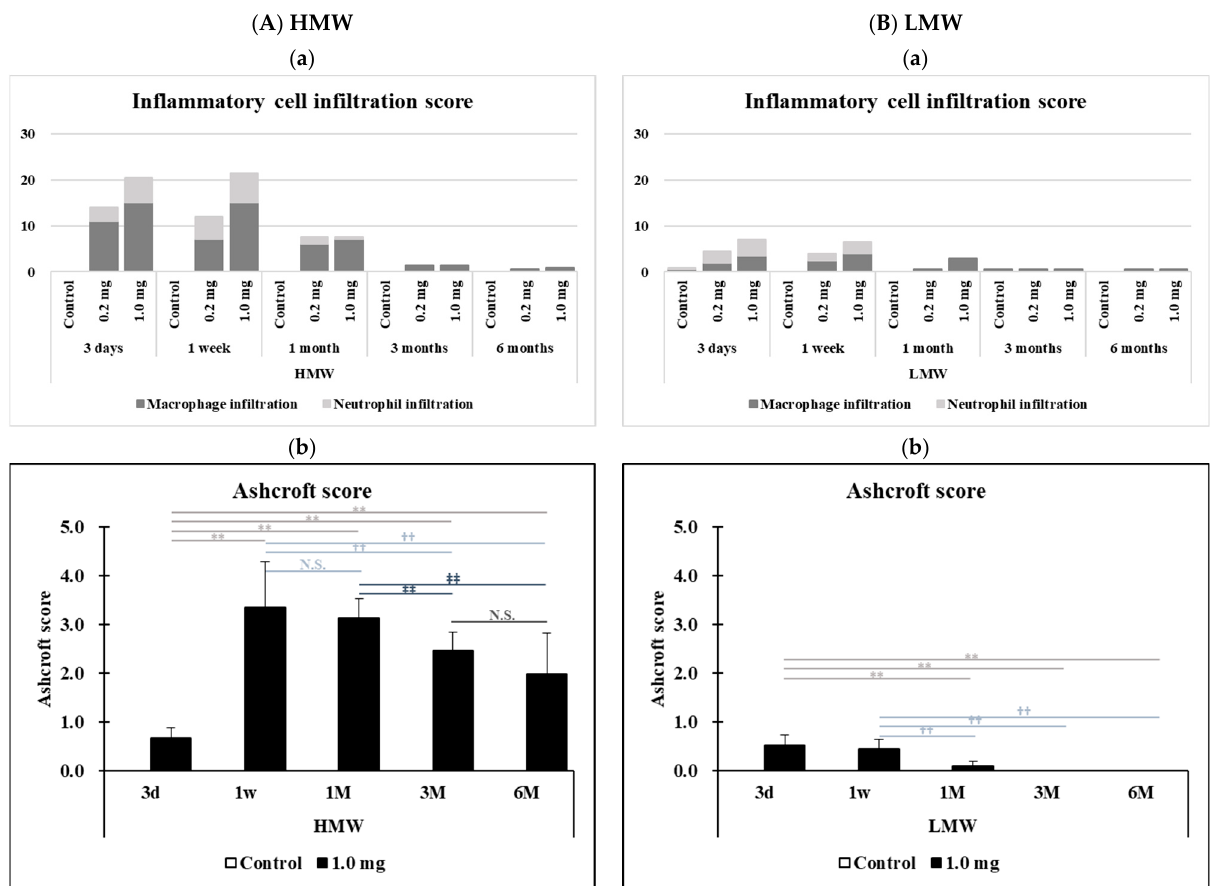
Figure 8. The histological evaluation of lung lesions. ( A ) HMW PAA-exposure group and ( B ) LMW PAA-exposure group, where ( a ) inflammatory cell infiltration score among the control, 0.2 mg-exposed, and 1.0 mg-exposed groups, and ( b ) Ashcroft score in the control group and 1.0 mg-exposure group. Inflammatory cell infiltration was observed in a dose-dependent manner, and was more severe and lasted longer in the HMW PAA-exposure group than in the LMW PAA-exposure group ( A ( a ), B ( a )). Pulmonary fibrosis was seen throughout the observation period in the HMW PAA-1.0 mg exposure group, whereas it was transient in the LMW PAA-1.0 mg exposure group. Pulmonary fibrosis was more severe in the HMW PAA-exposure group than in the LMW PAA-exposure group ( A ( b ), B ( b )). Data are presented as mean ± SE. (** p < 0.01, †† p < 0.01 and ‡‡ p < 0.01 indicate that there is a significant difference in the scores between the two groups, respectively. N.S. indicates that there is no significant difference in the scores between the two groups.).